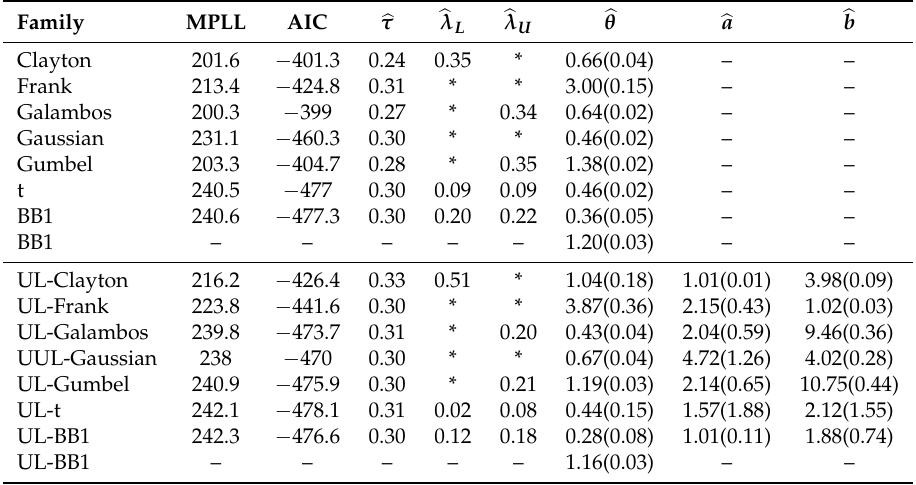
Table 4. MPLL, AIC, ˆ τ , ˆ λ L , ˆ λ U , and parameter estimates (standard error in parentheses) for the base and UL distorted copulas during post-crisis period.